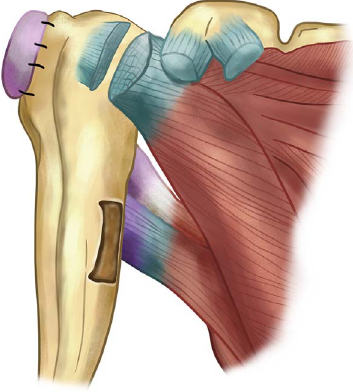
Figure 2. The L ’ Episcopo procedure. The contracted anterior tissues, such as subscapularis tendon, are released using Sever ’ s technique. Teres major and LD are detached from their insertions as an osteoperiosteal fl ap. Combined transfer of the tendons of LD and teres major to the posterolateral aspect of humerus aims to achieve external rotation in obstetric plexus